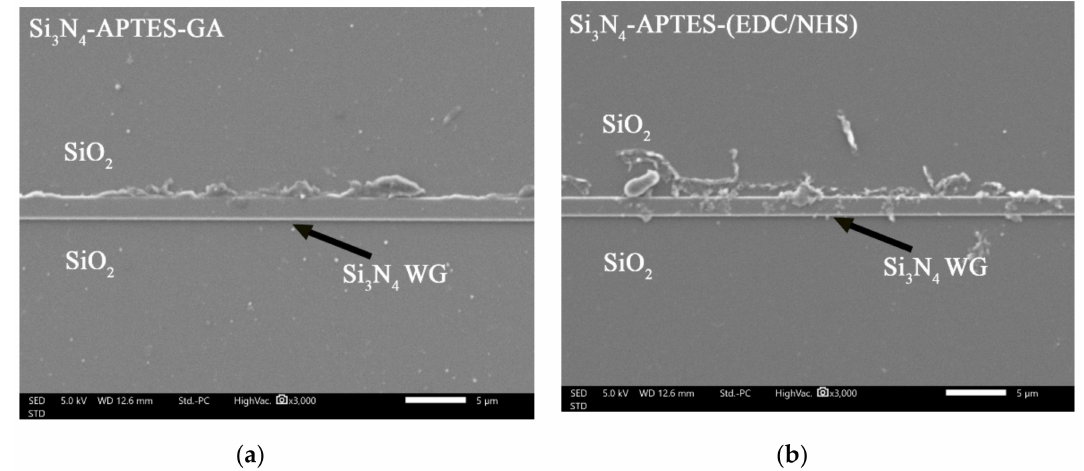
Figure 15. SEM images of anti-TNF-alpha coating of Si 3 N 4 waveguides using ( a ) APTES-GA technique and ( b ) APTES- (EDC/NHS)